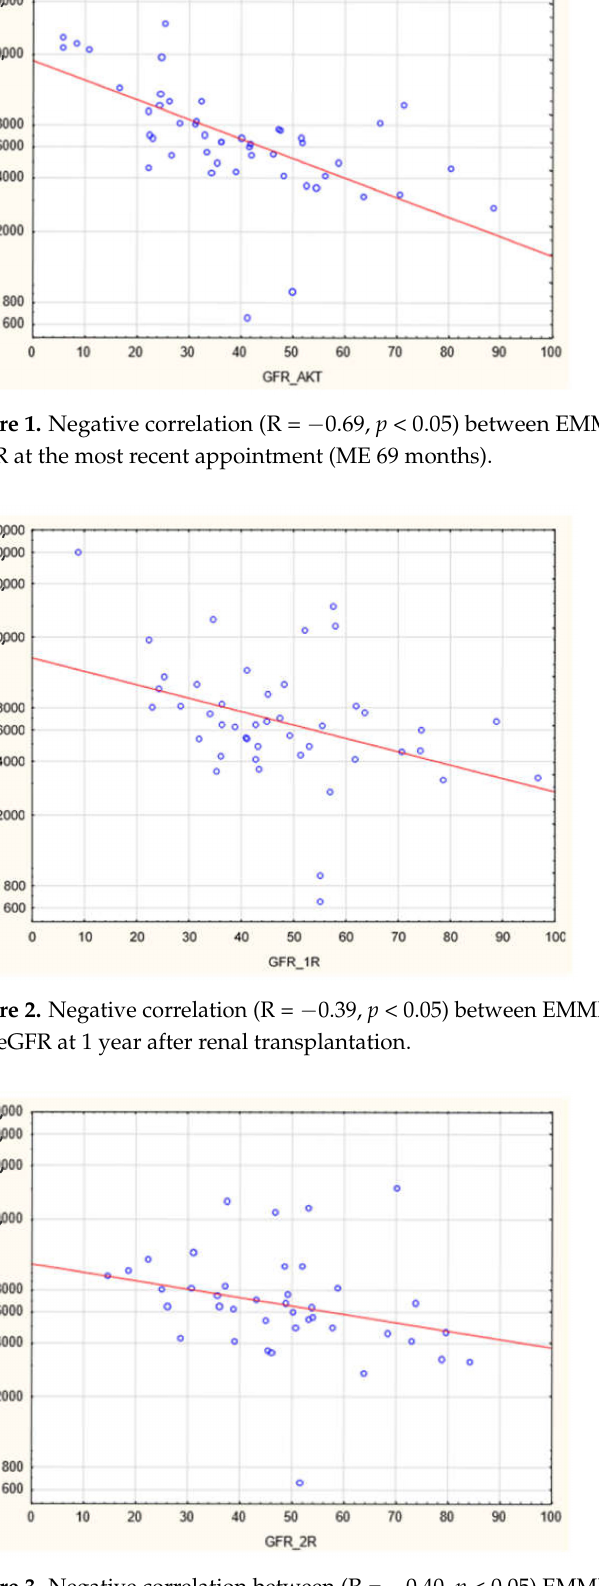
Figure 3. Negative correlation between (R = − 0.40, p < 0.05) EMMPRIN/CD147 serum concentration and eGFR at 2 years after renal